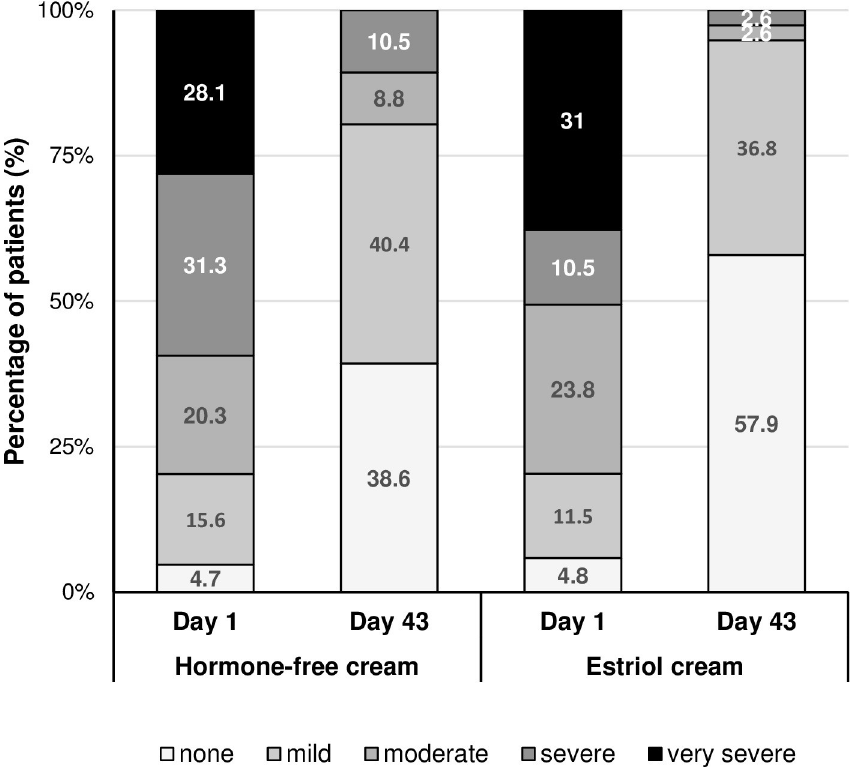
Fig 5. Dyspareunia severity. Percentage of patients for the assessment of dyspareunia severity (if sexually active). The total number of patients refers to sexually active patients at Day 1/ Day 43: Hormone-free moisturizing cream n = 64/ 57; Estriol cream n = 42/37. Scale severity score for dyspareunia: 0 = none, 1 = mild, 2 = moderate, 3 = severe, 4 = very severe.